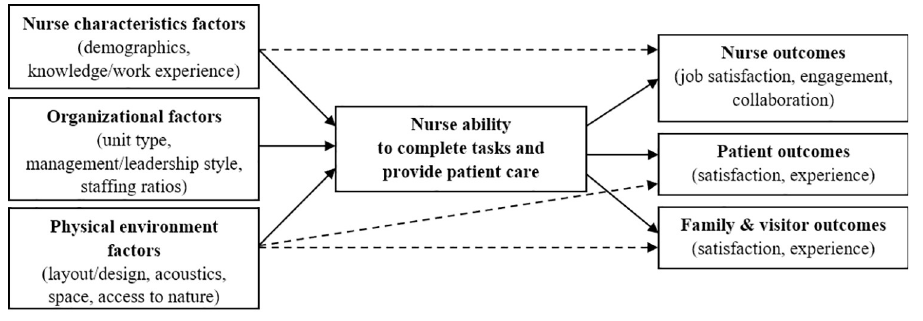
Fig 1. Conceptual diagram of theoretical framework. Hypothesized relationships shown with solid arrows, previously studied direct effects between factors and outcomes as dashed arrows.